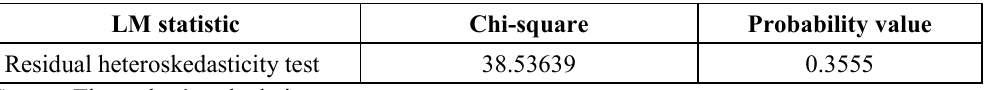
Table 10 . Residuals Heteroskedasticity Test Result